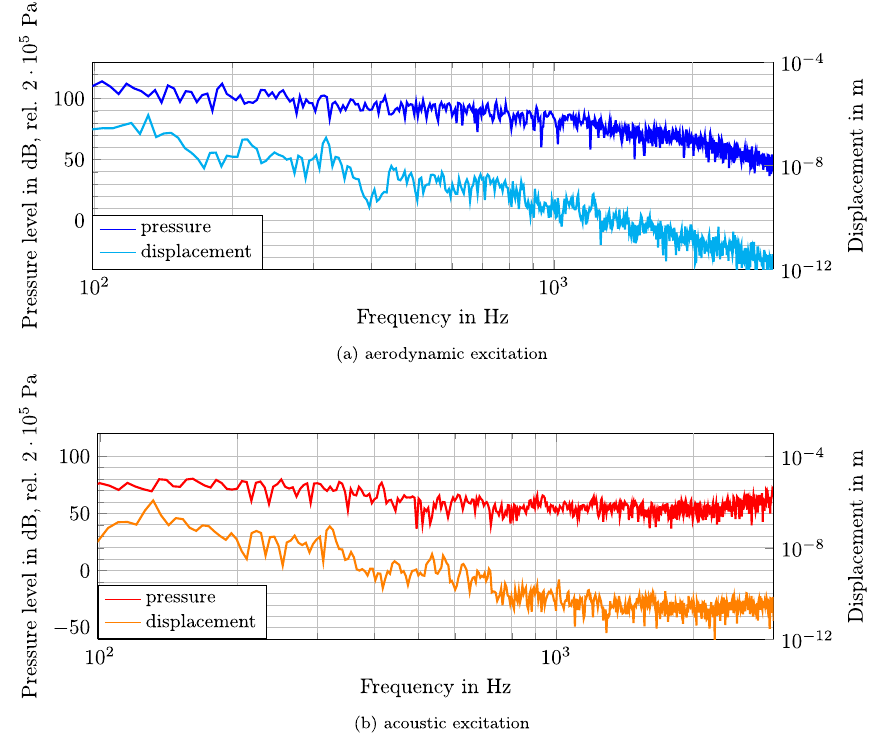
Figure 12. Relation of wall pressure fl uctuations and structural displacement at the center of the side